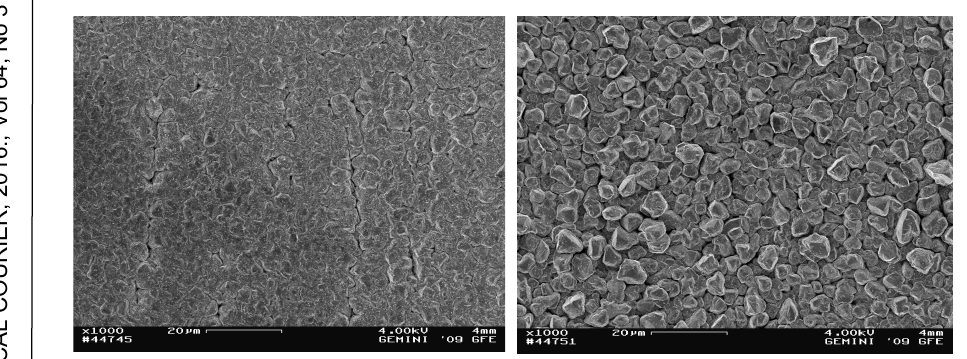
Figure 9 – SEM analysis of the Sn-Zn layers obtained from an electrolyte with 0.05 mol/l Sn; 0.1 mol/l Zn; 0.375 mol/l K4P2O7 and 1 g/l gelatine (60°C; pH=9.3; 20 min.); magnification: 1.000 x Рис . 9 – SEM анализ Sn-Zn слоев , полученных из электролита с 0.05 mol/l Sn; 0.1 mol/l Zn; 0.375 mol/l K4P2O7 и 1 g/l желатина (60°C; pH=9.3; 20 мин .); масштаб увеличения : 1.000 x uve ć anje: 1.000 x